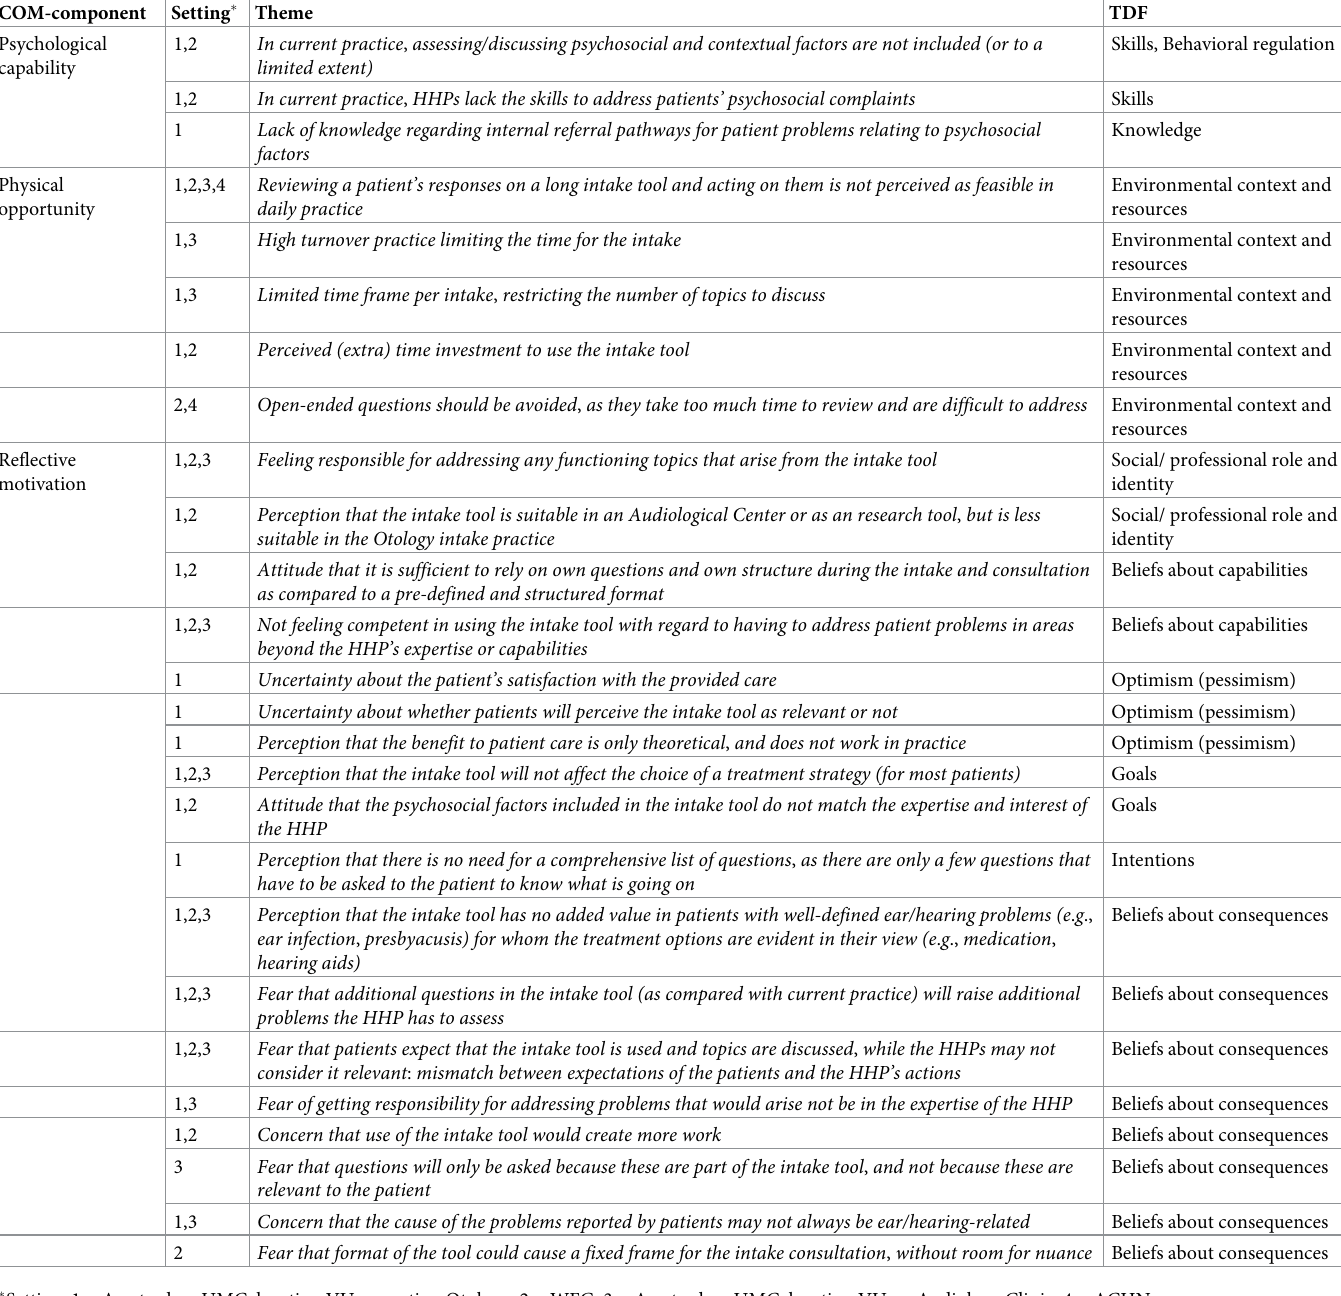
Table 3. Identified barriers to the use of the ICF-based intake tool as perceived by hearing health professionals. COM-component Setting � Theme TDF Psychological